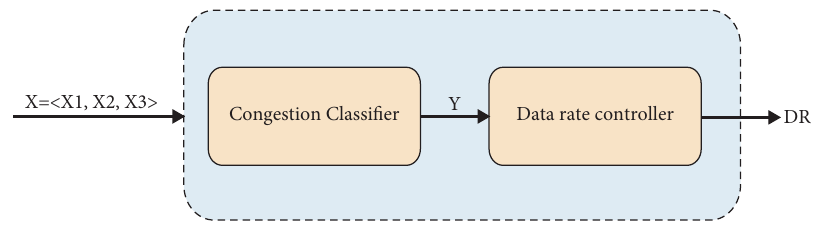
Figure 2: Improved adaptive data rate controller